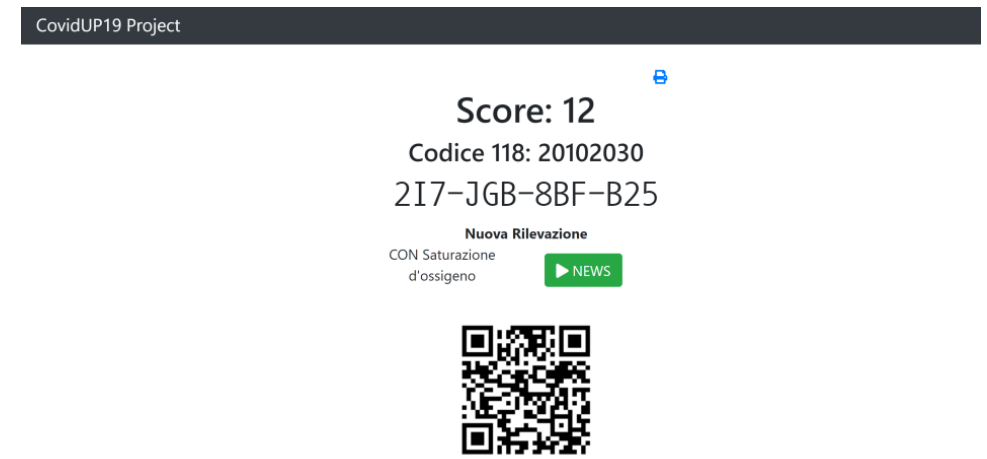
Figure A3. Descriptive Analysis of the EMS Questionnaires about the Use of NEWS. A crew personnel questionnaire was designed to collect feedback about the use of NEWS. Each participant was asked to complete the questionnaire based on a seven-point Likert scale (LS) designed to explore the applicability on the field, potential implementation as a tool to measure the clinical situation at scene, and time spent in calculating the score. The questionnaire data were collected anonymously with a JotForm form (JotForm, San Francisco, CA, USA) developed for the study. Forty-six EMS personnel out of sixty-nine (67%) involved in the study filled out the whole questionnaire; among them, the majority (80%) were BLS-skilled rescuers, while the remaining 20% were nurses attending the ILS vehicles. Among the responders, 48% recruited more than twenty cases with no mention of any kind of difficulties (98%). Since the majority of the responders (74%) had never used the NEWS before, we investigated whether the initial training phase had been exhaustive enough in providing all the necessary contents to use NEWS properly: a total of 54% and 41%, respectively, agreed and strongly agreed, according to the proposed Likert scale. Moreover, the developed web application turned out to be clear, comprehensible, and easy-to-use for 50% and 39% of the responders, which, respectively, strongly agreed and agreed with the proposed statements. Furthermore, 54% agreed and 39% strongly agreed that NEWS did not interfere with the usual clinical practice in terms of time; only 4% and 2%, respectively, partially agreed and were uncertain. Concerning its usefulness, 17% and 50% of answers agreed and strongly agreed, respectively, in stating that NEWS could be a potentially useful and relevant tool to assess patients in out-of-hospital settings. Approximately half of the EMS personnel who completed the questionnaire considered the use of NEWS as a valid supplementary tool to recruit ALS vehicles in those critical cases in which advanced life-support skills are required; an additional tool to support ambulance personnel in decision making about the severity of the return code; and an integrative tool to enhance, in terms of time and suitability, the admission to the emergency department triage. Lastly, we asked whether participants would deploy the score into emergency out-of-hospital clinical practice. The results were characterized by heterogeneity, since 22% answered absolutely yes, 39% yes, 22% probably yes, and 11% probably no. From the results, NEWS application was not perceived as an obstacle in terms of time and operativity during the management of urgent and emergency situations. In fact, as 54% agreed and 39% strongly agreed that NEWS did not interfere with the usual clinical practice in terms of time but rather was a valid adjunct to the clinical decision for urgent care and/or hospital admission